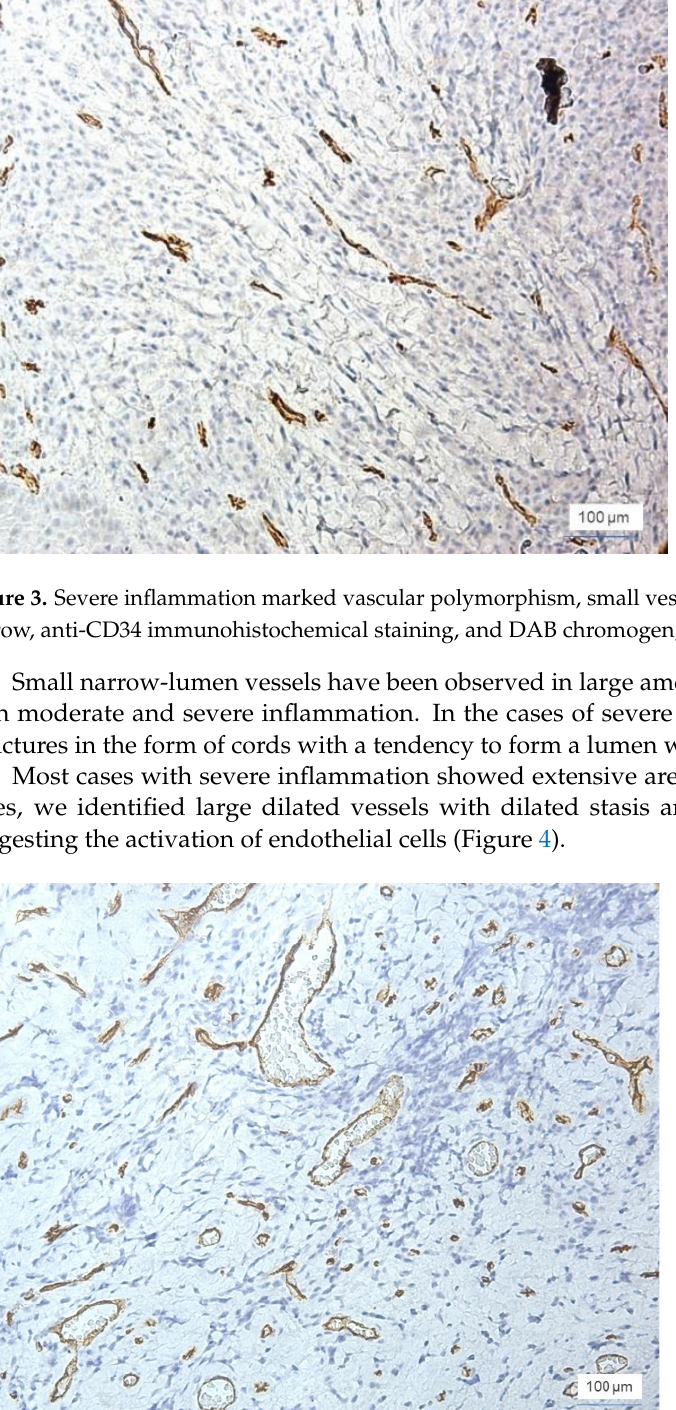
Figure 4. Large dilated and branched vessels, anti-CD34 immunohistochemical staining, and DAB chromogen, ×200 magnification.